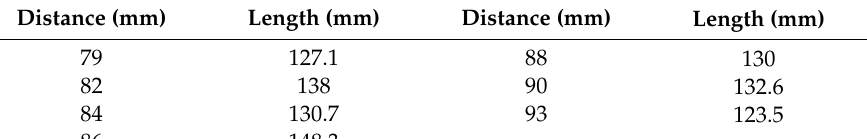
Figure 7. Sampling length under different open diameters. Table 4. Simulation results under different open diameters.